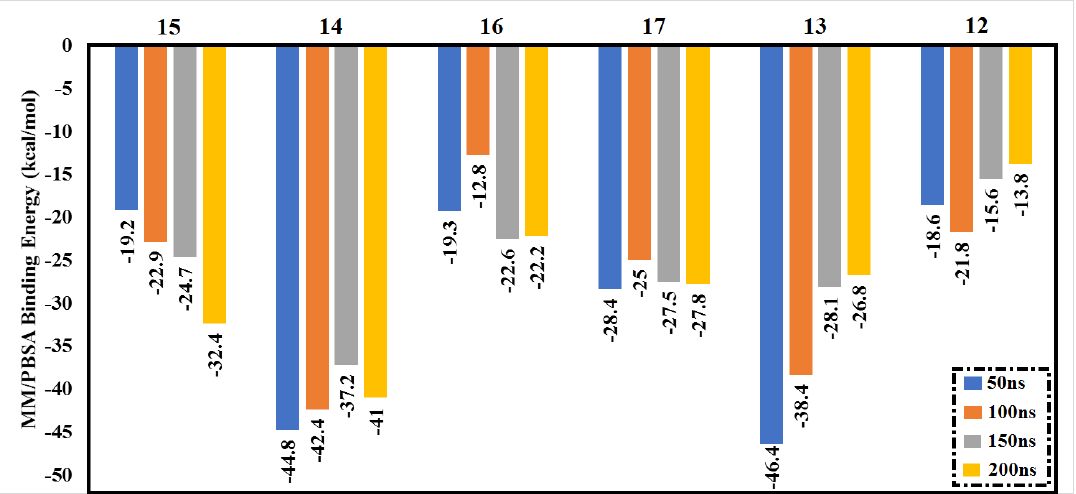
Figure 2 . Estimated MM/PBSA binding energies for the best six drug candidates as Omicron inhibitors.